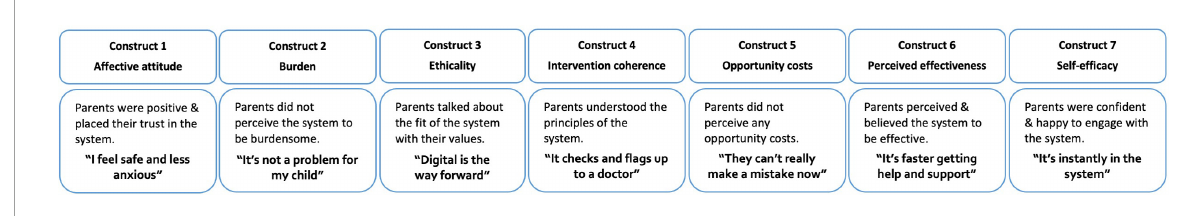
FIGURE2 Domains of the Theoretical Framework of Acceptability (29) as applied to